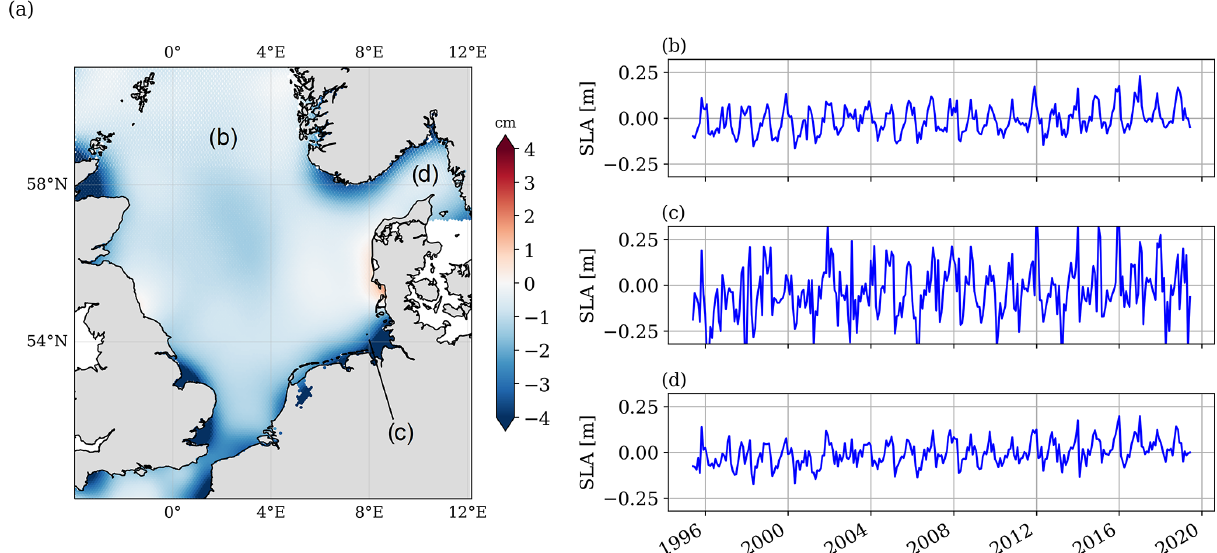
Figure 3. Mean sea level anomalies over the period May 1995 to May 2019 in the North Sea (a) and three examples of time series of sea surface anomalies at different locations (b–d)